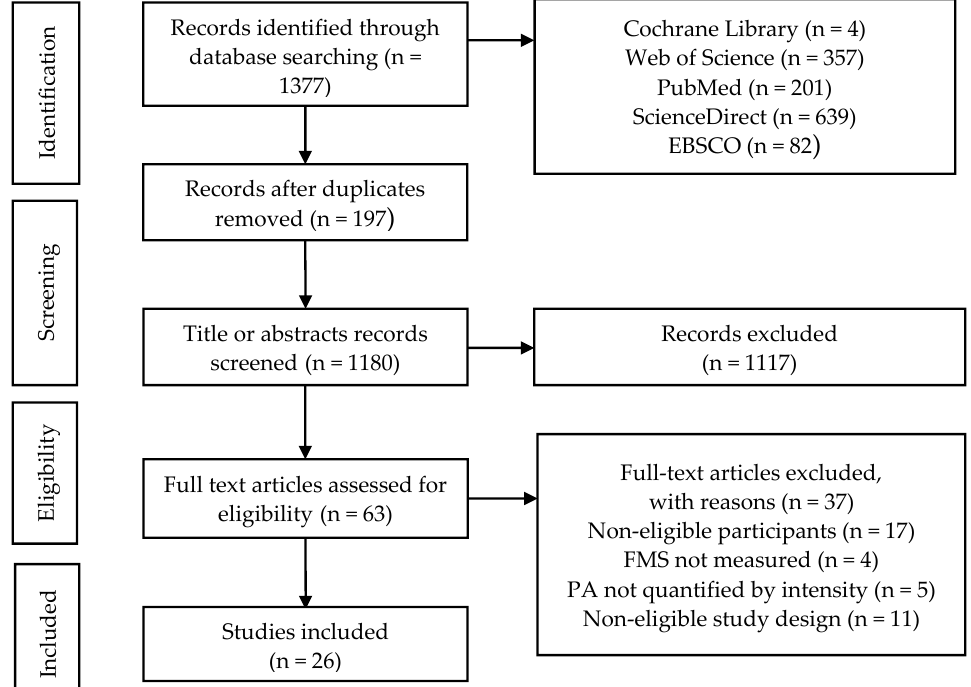
Figure 1. The Process of Articles Retrieve.